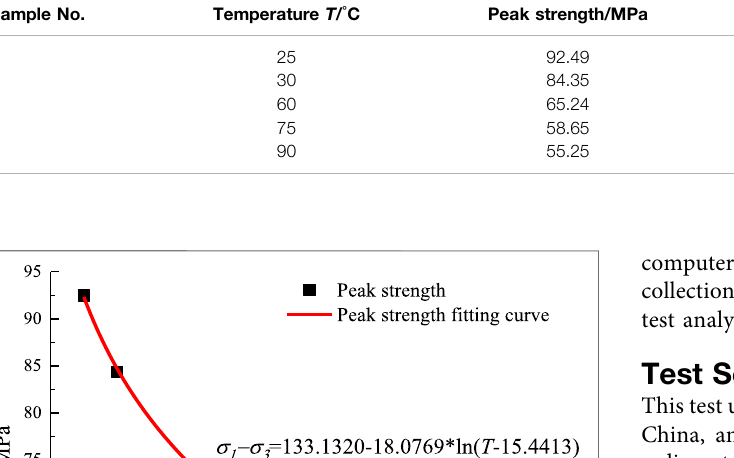
TABLE 2 | Mechanical parameters such as peak strength of sandstone in triaxial compression. Sample No.